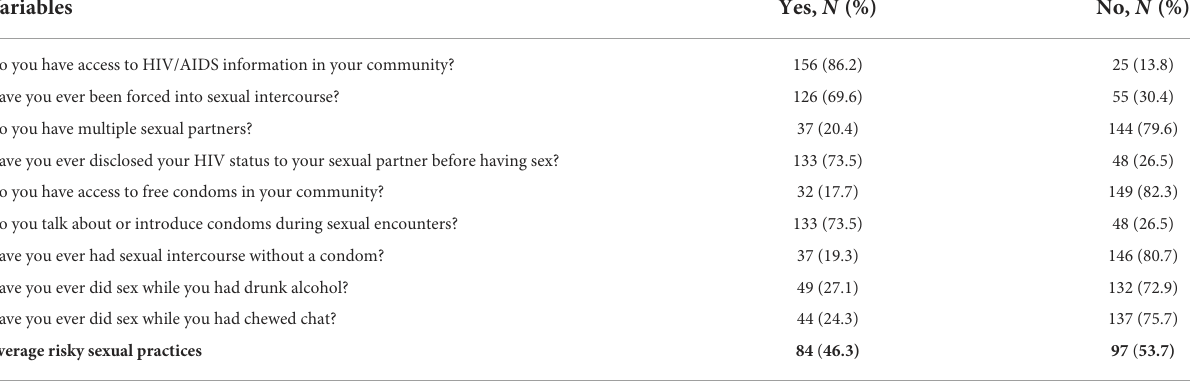
TABLE 4 Risky sexual practices of respondents in Andabet district, Ethiopia,